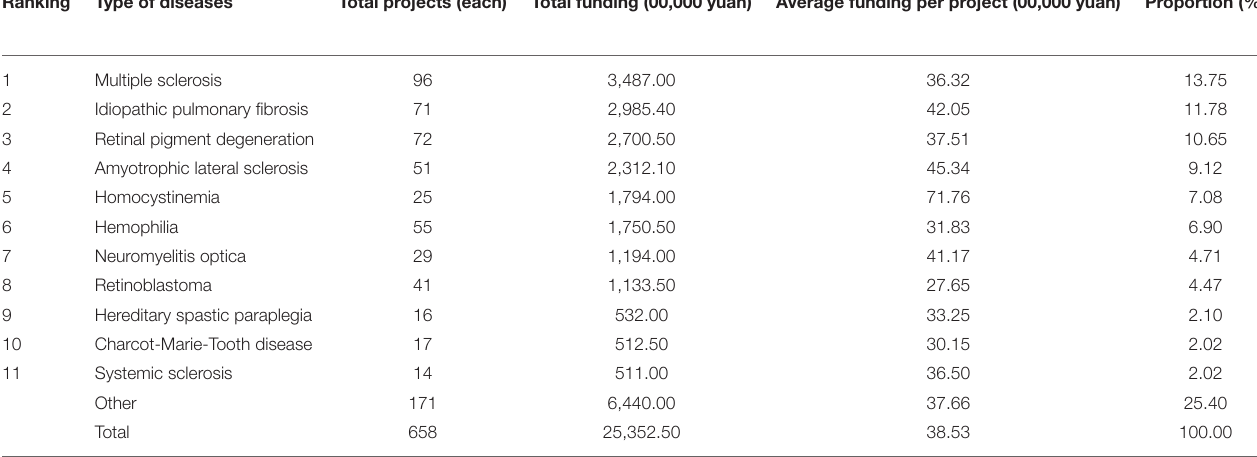
TABLE 4 | R&D input in the main types of rare diseases by NSFC.